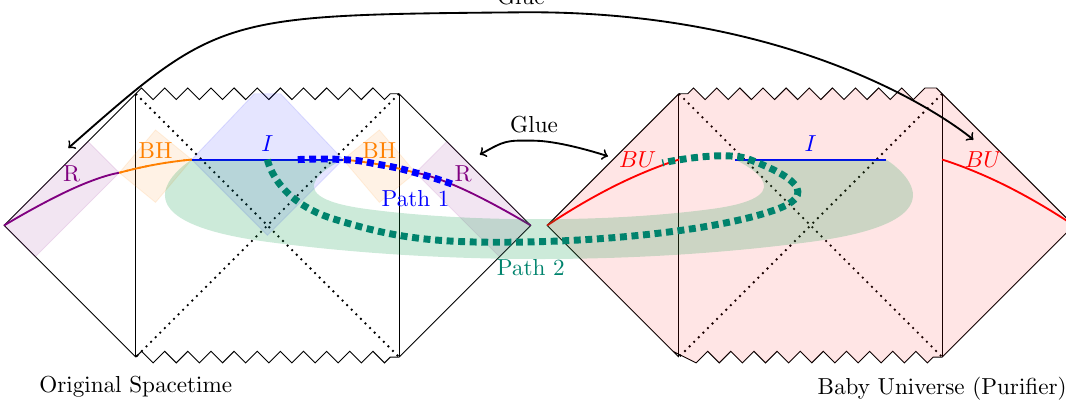
Figure 3 . Schematic picture of the geometry of the AdS black hole coupled the bath CFT (left Penrose diagram) and the baby universe geometry (right red Penrose diagram) connected by the Einstein-Rosen bridge (transparent green shaded region), corresponding to the state (2.14). After the Page time, the fine-grained Hawking radiation R is the union of the Hawking radiation R (violet region) and the baby universe BU (red region). We regard the above spacetime describing this union by gluing two distinct asymptotic boundary regions BU and R . The island region I is connected to the fine-grained Hawking radiation R ∪ BU through two paths, path 1 and 2. The path 1 (thick blue dotted line) intersects with the entanglement wedge of the black hole BH (orange shaded region), but the path 2 (thick green dotted line) does not intersect with